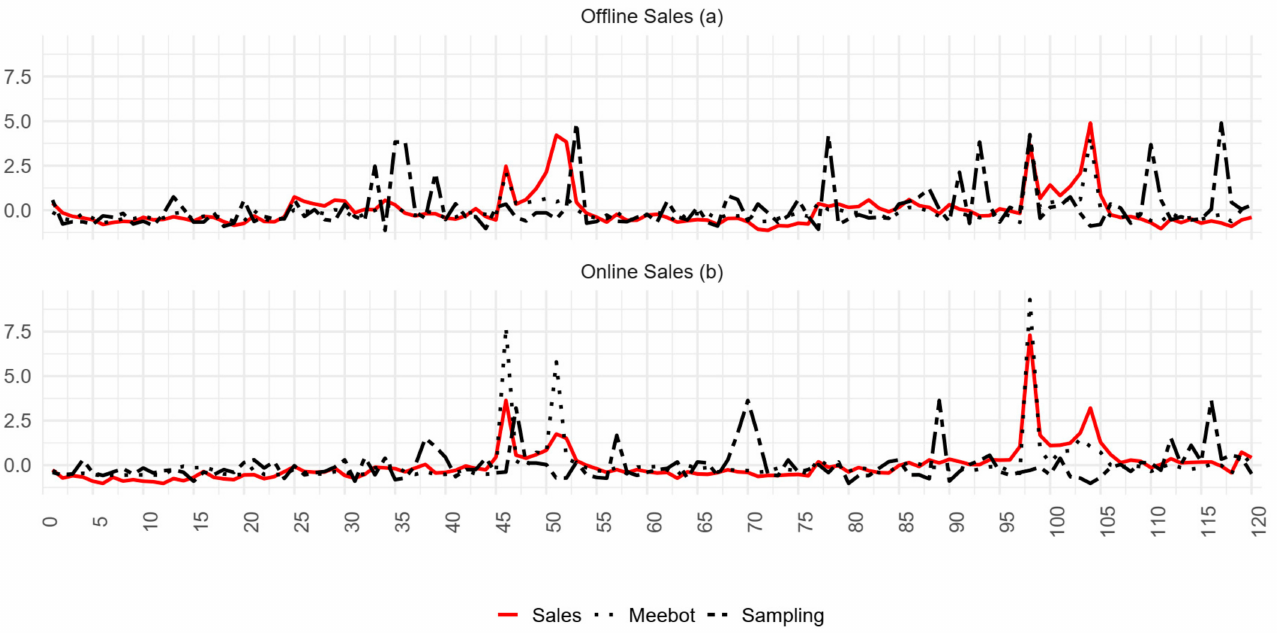
Figure 3. ( a , b ) plot the original weekly Sales. Offline sales ( a ) and online sales ( b ) series and their respective sampling and meboot counterparts. The horizontal axis represents time in weeks and the vertical axis represents the standard deviation of the standardized sales